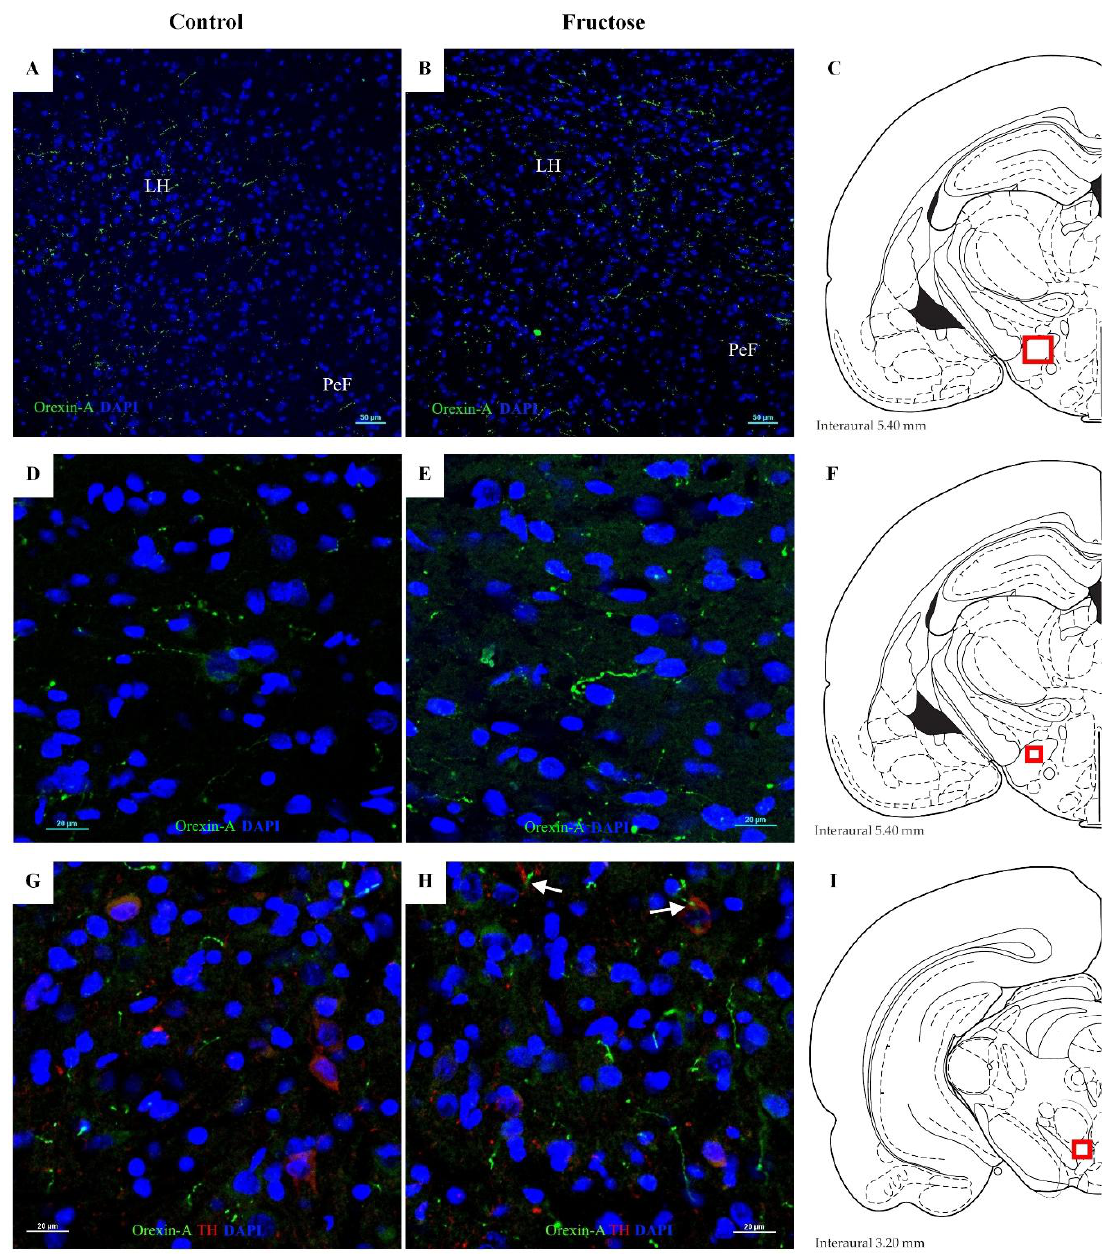
Figure 6. Fructose induces orexin A expression in rat brain. ( A , B ) Panoramic view (10 × ) showing the immunofluorescence staining of orexin A (green) and DAPI (blue) in the lateral hypothalamic area (LH) and perifornical nucleus (PeF). ( D , E ) Photomicrographs (20 × ) emphasizing the increase of orexin A immunoreactivity in the LH after treatment with fructose. ( G , H ) Ventral tegmental area (VTA) sections were immunostained simultaneously with orexin A (green), tyrosine hydroxylase (TH) (red) and DAPI (blue). Arrows indicate positive orexin A signaling that overlaps with dopaminergic neurons. Photomicrographs taken with the 20 × objective were zoomed by applying Nyquist sampling (3.46 × ). ( C , F , I ) Diagrams showing the localization of the analyzed regions (red square) according to Paxinos and Watson [32]. N = 3 per group.